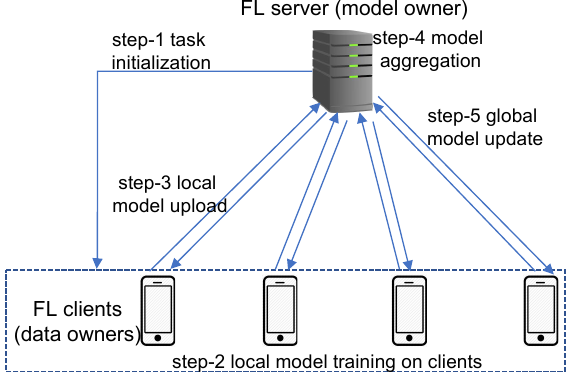
Figure 1. The framework architecture of federated